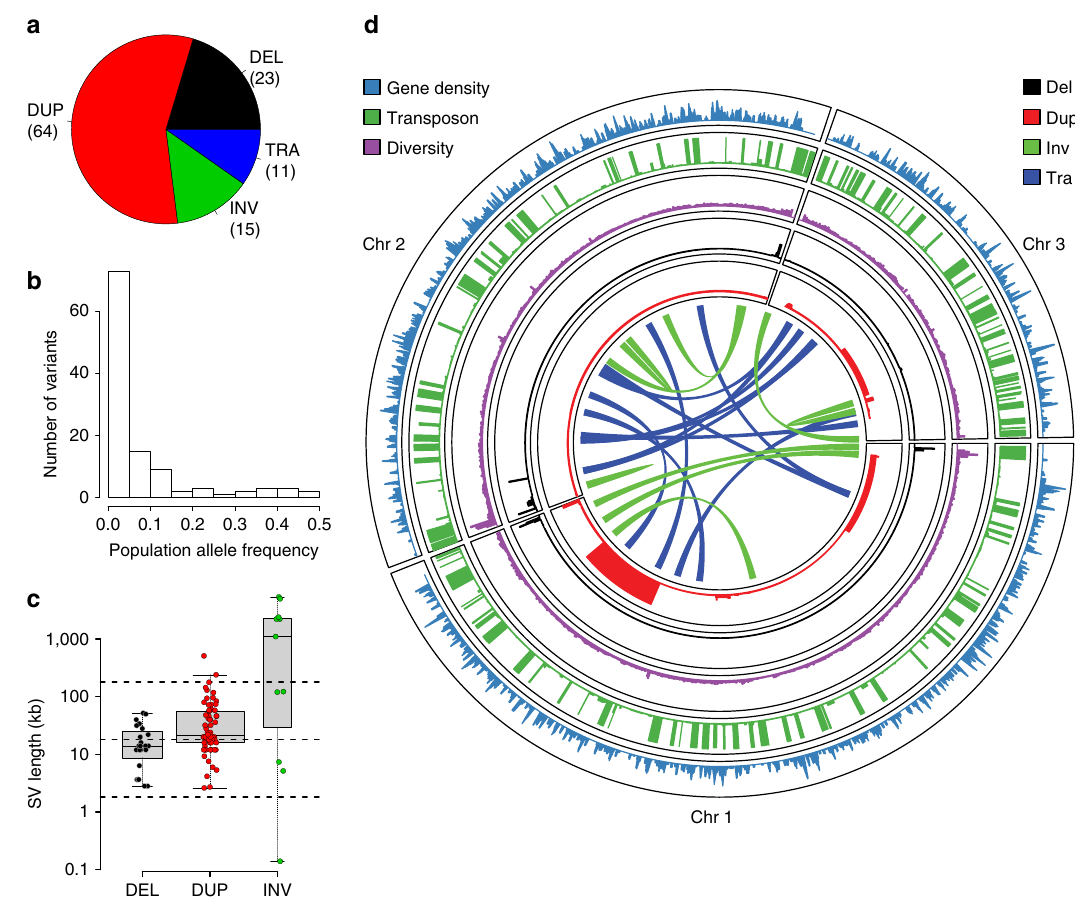
Figure 1 | Characteristics of SVs in S. pombe. ( a ) Relative proportions of SVs identified. Duplications (DUP) were the most abundant SVs, followed by deletions (DEL), inversions (INV) and translocations (TRA). ( b ) Population allele frequency distribution of SVs, showing the frequencies of less abundant alleles in the population (minor allele frequencies). ( c ) Length distributions of SVs, log 10 scale. Deletions were smallest (2.8–52kb), duplications larger (2.6–510kb) and inversions often even larger, spanning large portions of chromosomes (0.1kb–5,374kb, see d ). Horizontal dotted lines show the size of chromosome regions that contain an average of 1, 10 and 100 genes in this yeast. Box plots indicate the first quartile, the median and the third quartile; whiskers extend to the most extreme data point, which is no more than 1.5 (cid:2) the interquartile range from the box. ( d ) Locations of SVs on the three chromosomes compared with other genomic features. From outside: density of essential genes, locations of Tf -type retrotransposons, diversity ( p , average pairwise diversity from SNPs), deletions (black), duplications (red) and breakpoints of inversions and translocations as curved lines inside the concentric circles (green and blue, respectively). Bar heights for retrotransposons, deletions and duplications are proportional to minor allele frequencies. Diversity and retrotransposon frequencies were calculated from 57 non-clonal strains as described by Jeffares et al.